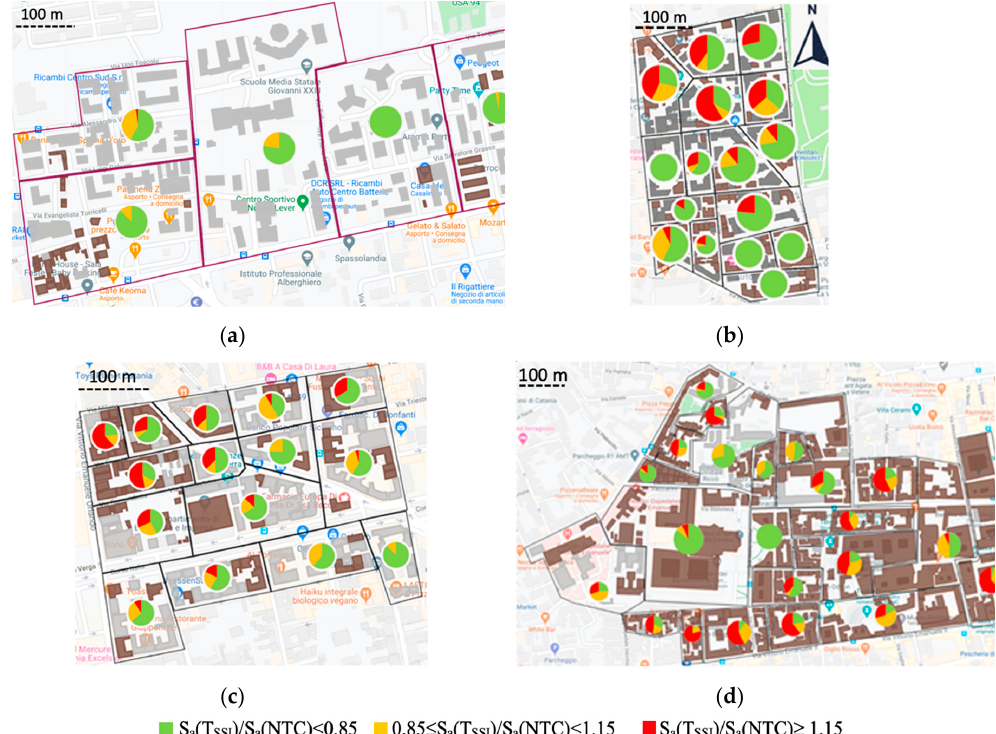
Figure 23. Spatial distribution of S a ( T SSI ) / S a ( NTC2018 ) ratios for the 2018 seismic input: ( a ) west area; ( b ) northeast area; ( c ) north Old Town; ( d ) south Old Town.